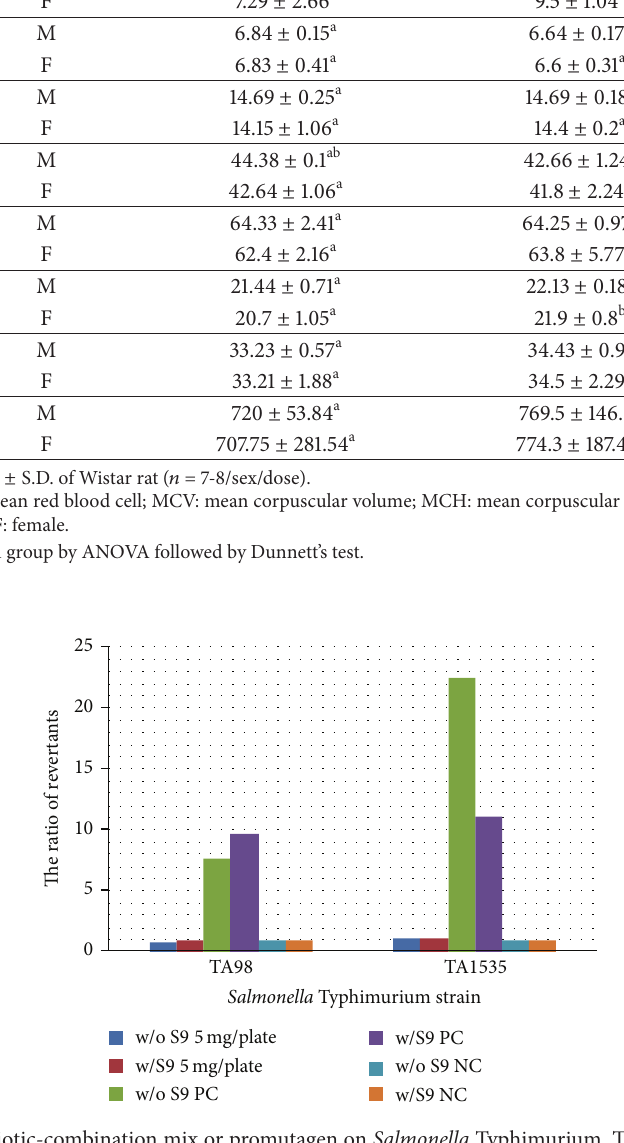
Table 2: Haematological findings in rats that were treated orally with multiple LAB strains for 28 days. Parameters